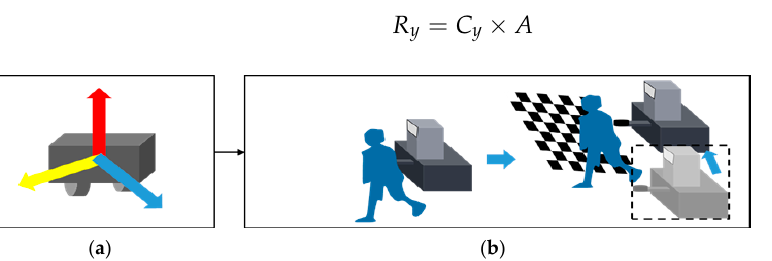
Figure 6. A procedure for updating content based by the distance between trainee: ( a ) calculation of training distance based on robot‘s travel distance; ( b ) content updates based on training distance.